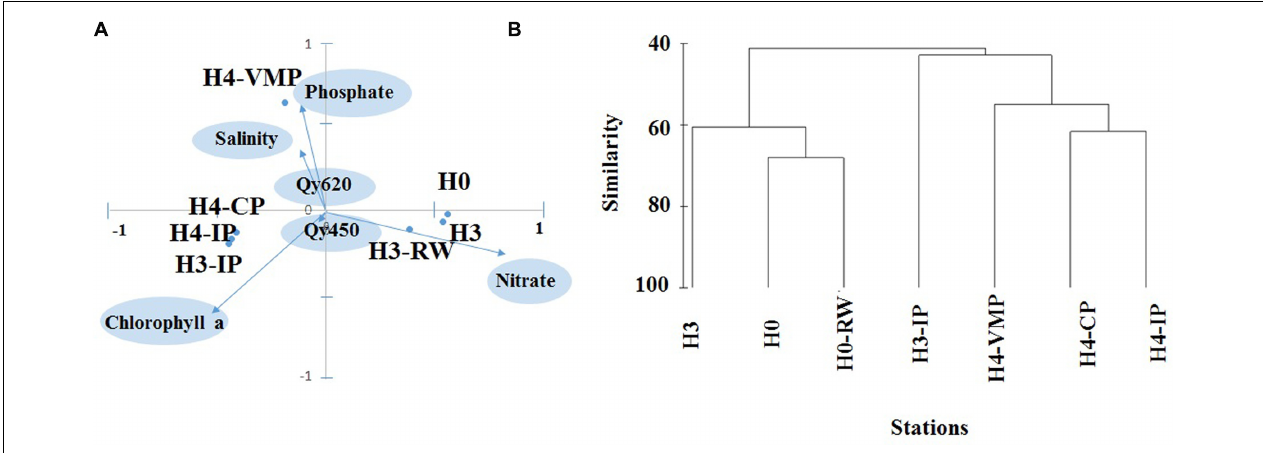
FIGURE 3 | (A) Statistical multivariate principal component analysis to evaluate environmental similarity among stations including salinity, NO 2 − , PO 43 − , and NO 3 − concentrations, chlorophyll a concentration, photosynthetic efficiency of photosystem II for microalgae (Qy450) and cyanobacteria (Qy620). Stations are plotted according to their the first and second principal component (PC) scores; environmental variables are plotted according to PC1 and PC2 coefficients; because PC scores were in the range − 100 to 100, they were divided by 100 and the two coordinate systems were overlaid at the same scale (ranging from − 1 to 1 for both × and y -axis). (B) Group average cluster of station similarity based on microalgae abundance data across seven stations studied.